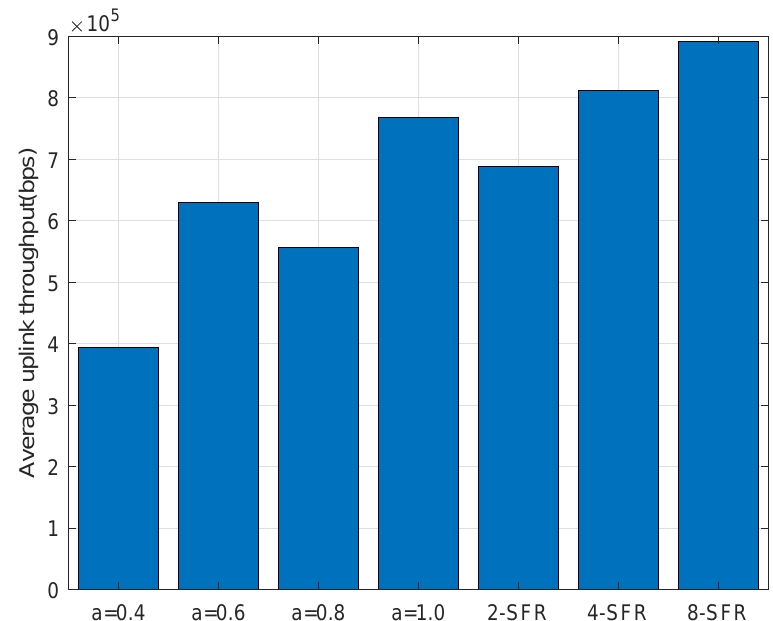
Figure 9. Average throughput in the